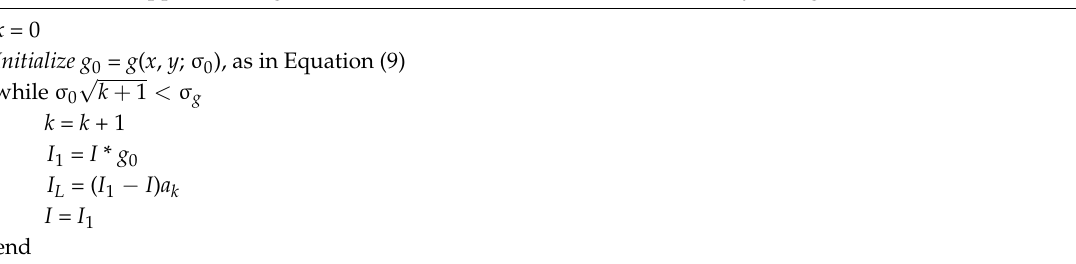
Algorithm 3. Approximating normalized LoG with DoG in the case of fisheye